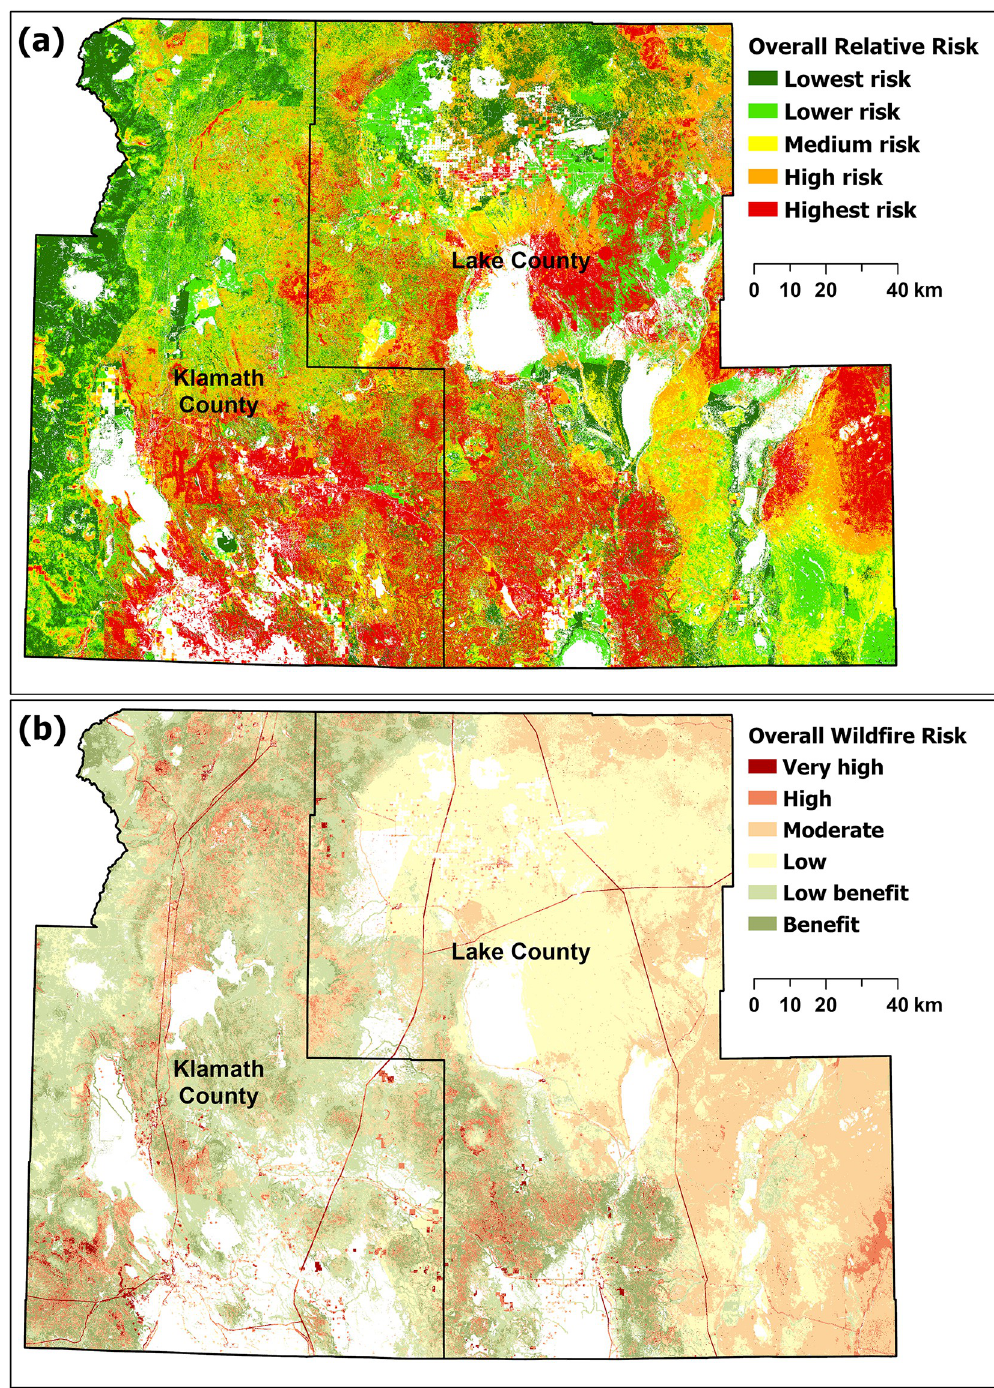
Fig 10. Regional comparison for Klamath and Lake County Oregon between overall relative risk as assigned by EFPRRA (a) and the overall wildfire risk calculated by QWRA 2018 [16] (b).